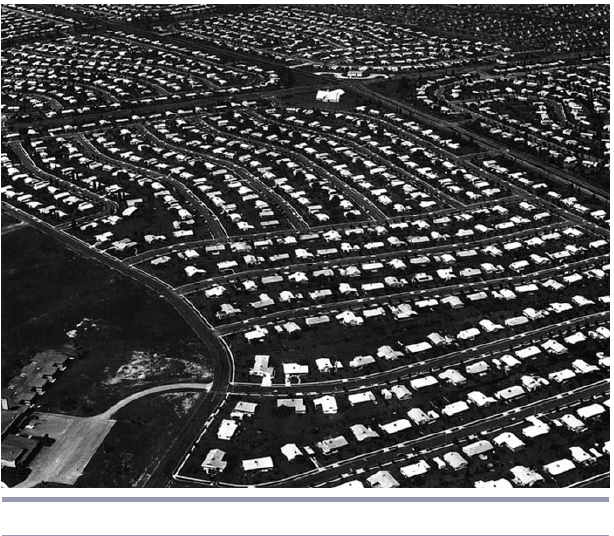
Fig. 1 . Levittown, Pennsylvania. (https://commons.wikimedia. org/wiki/File:LevittownPA.jpg)